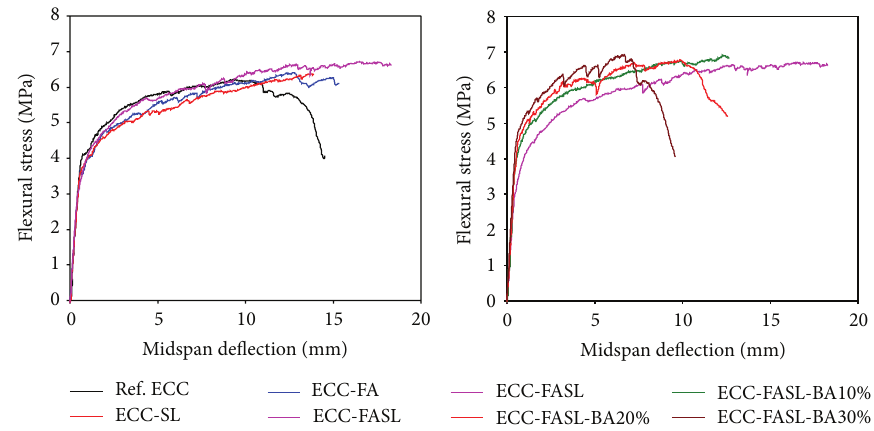
Figure 8: Flexural stress-midspan deflection behavior of all ECC mixtures and comparison.